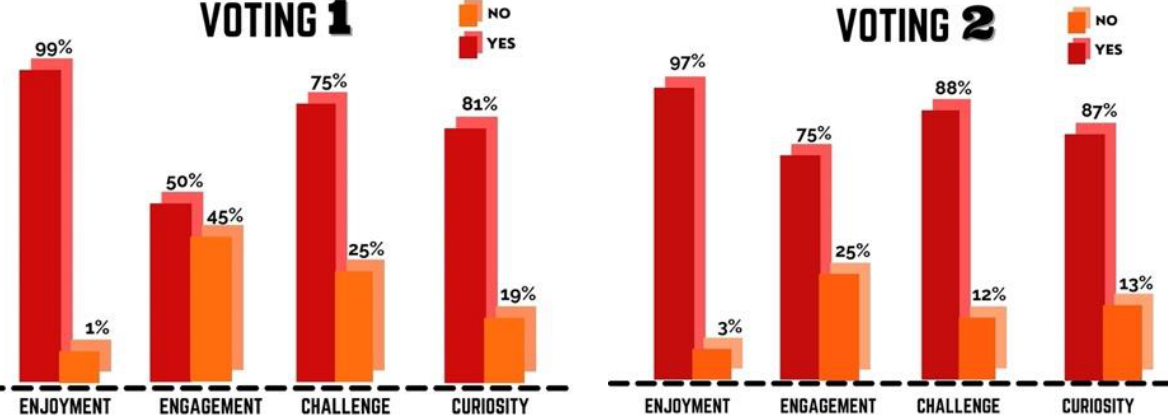
Figure 5. Result of the votes made on the Zoom platform, after the didactic technique of ( voting 1 ) dialogic exposition and ( voting 2 ) gamification, during the class of Greek prefixes and suffixes applied in Spanish words. In both cases, the students reported experiencing states of curiosity, challenge, engagement (concentration), and enjoyment. However, the achievement of these states after the gamification technique is more noticeable.